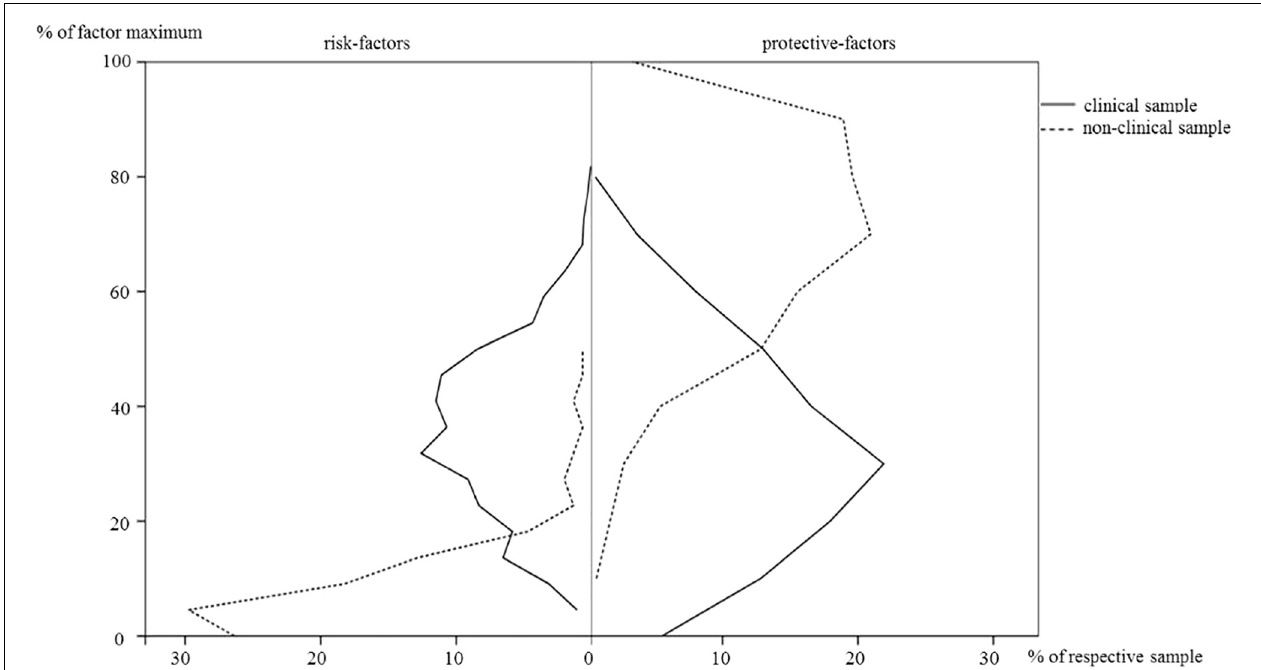
FIGURE 1 | Percentages of corrected risk- and protective-factors in the clinical and non-clinical